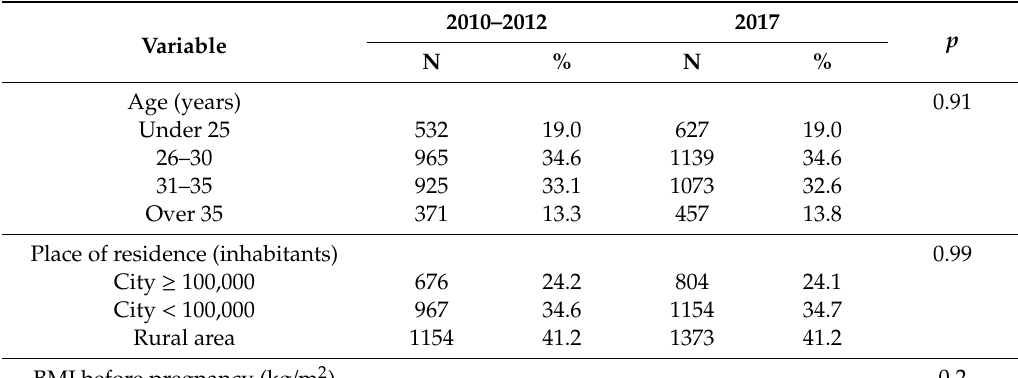
Table 1. Characteristics of the study